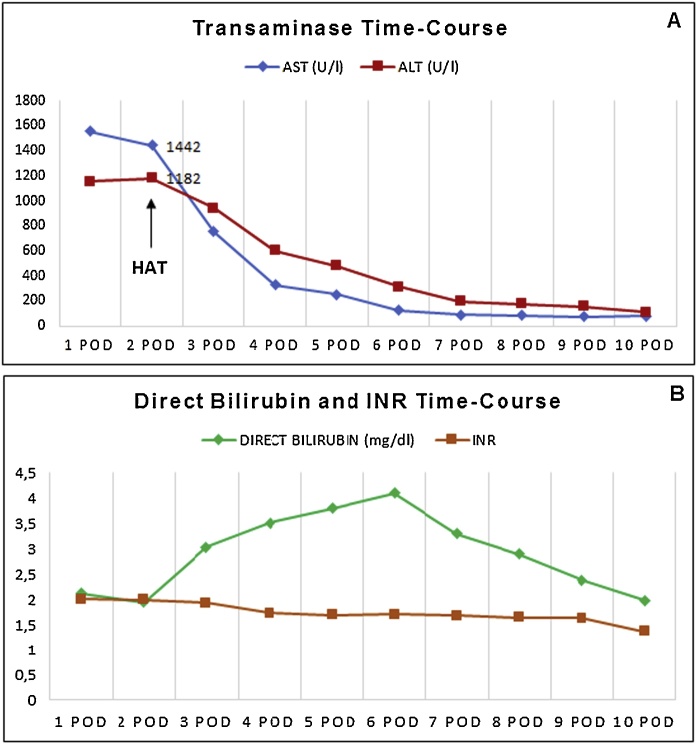
Recipient liver function tests within 10 post operative days: (A) ALT, alanine aminotransferase; AST, aspartate aminotransferase; (B) Bilirubin and Prothrombin time (PT-INR).